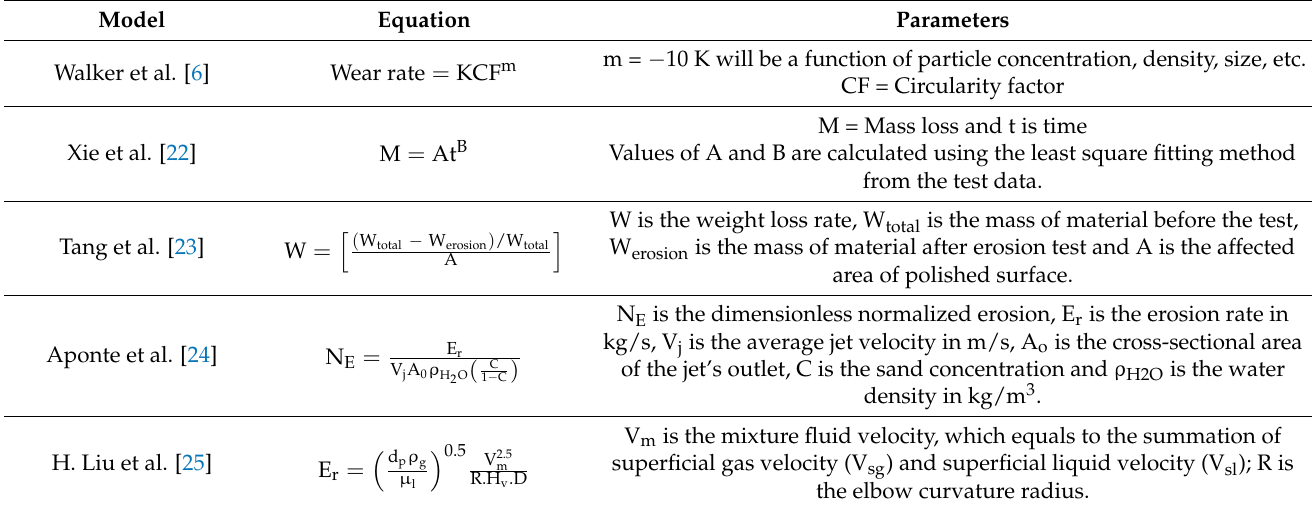
Table 1. Erosion correlations developed by different investigators.